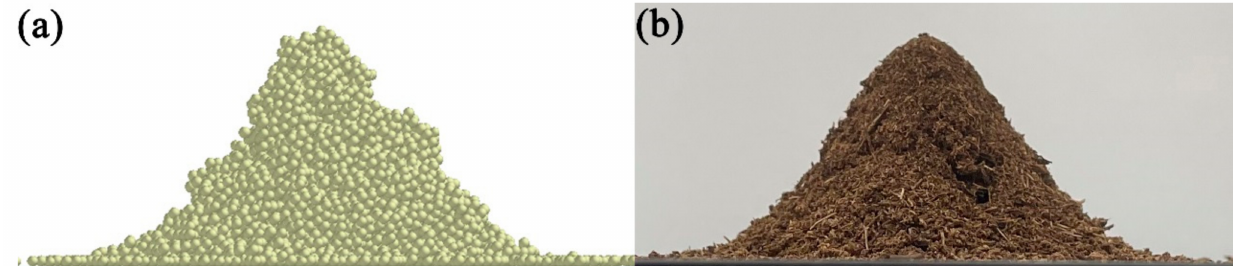
Figure 4. Comparison of the shape of peat pile between the ( a ) simulation test and ( b ) physical